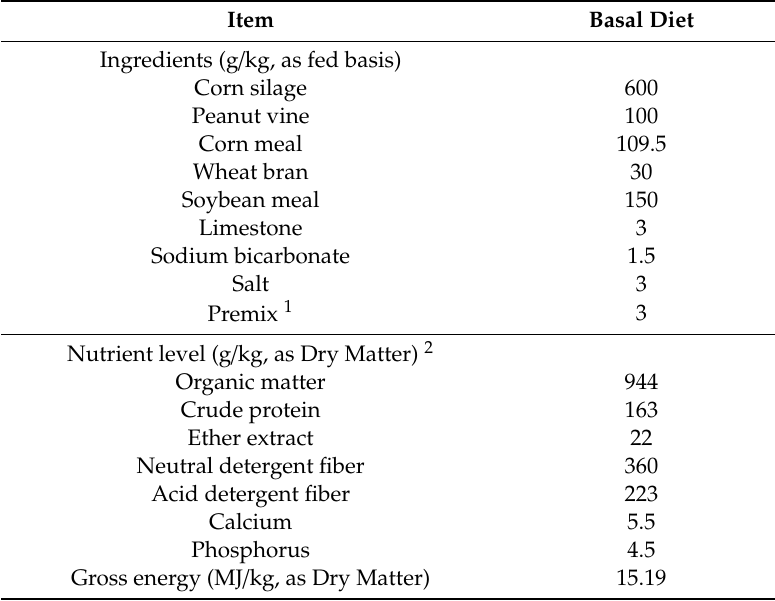
Table 1. Ingredients and nutrient level of the basal diet for growing lambs. Item Basal Diet Ingredients (g / kg, as fed basis) Corn silage 600 Peanut vine Corn meal